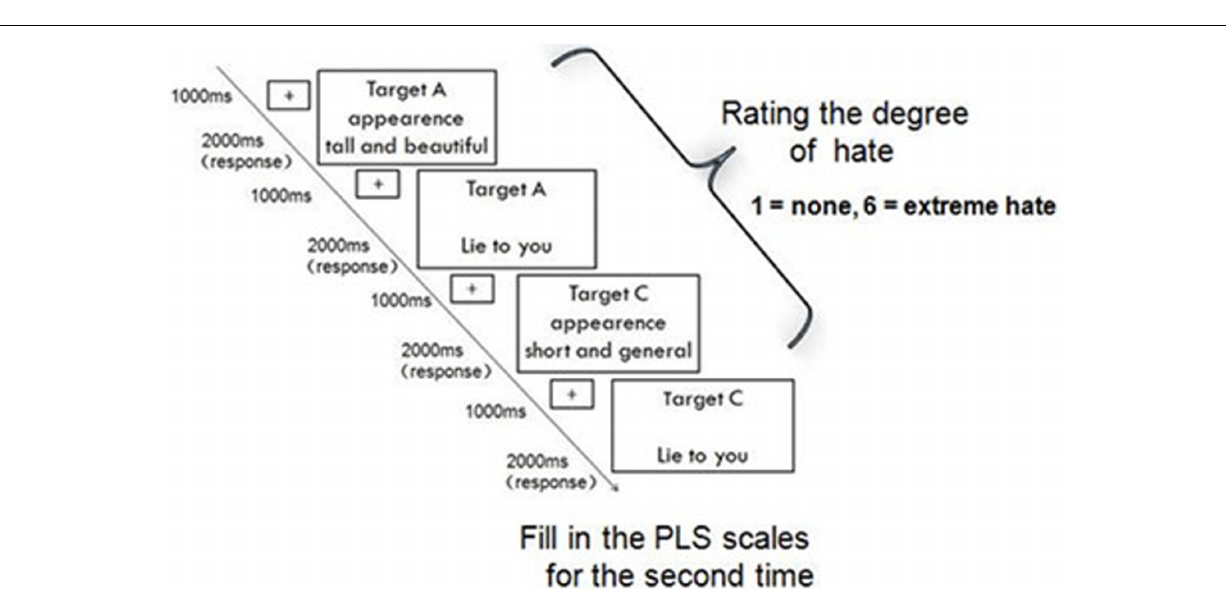
Part 1 ( Figure 1 ), and feelings of hate toward the targets in Part 2 ( Figure 2